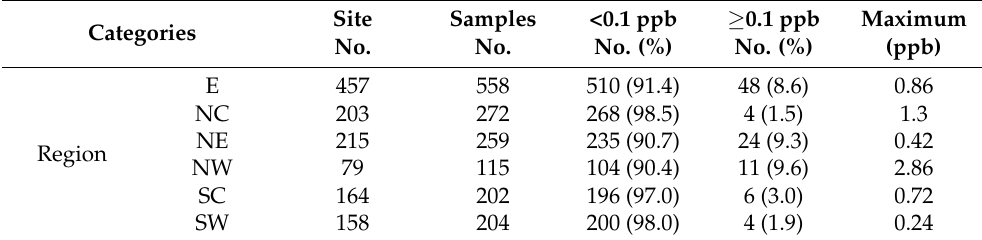
Table 9. Occurrence of DEA in Private